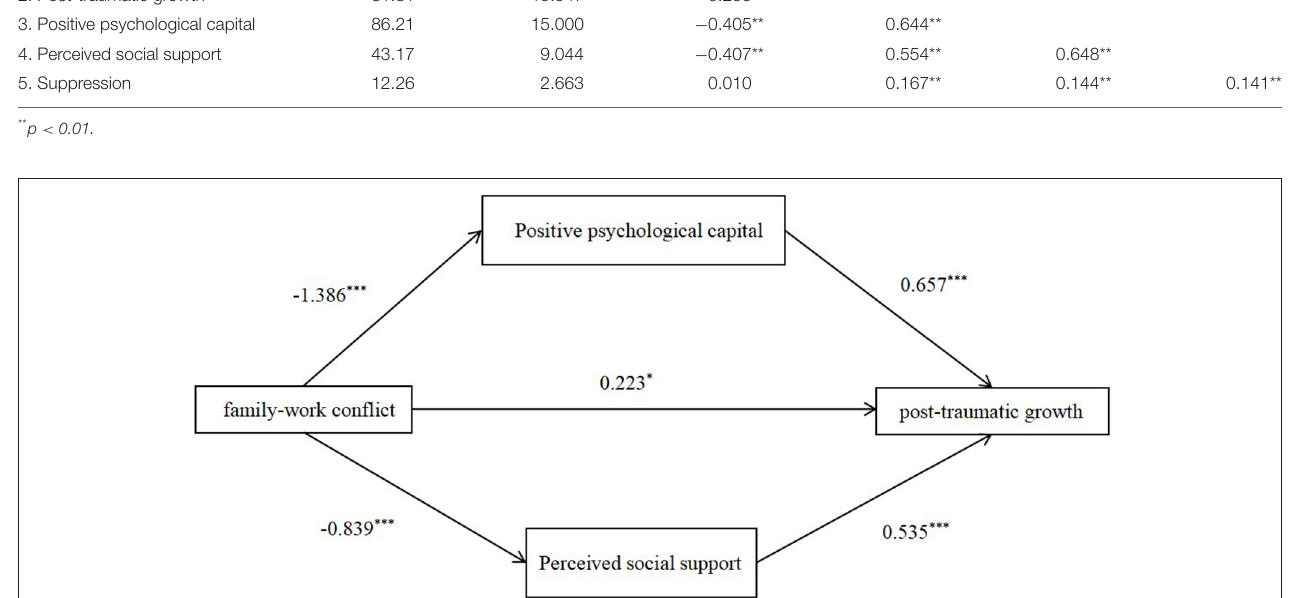
FIGURE 1 | The mediating effect of positive psychological capital and perceived social support. * p < 0.05, *** p < 0.001.